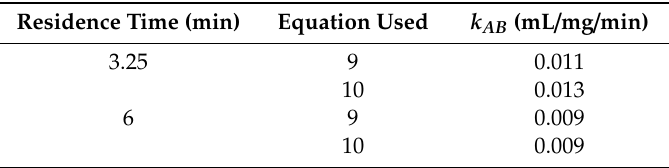
Figure 8. Linear regression fit of data to Adams–Bohart model. Values from these regressions were used in the calculation of kinetic constants in Tables 2 and 3. Table 2. Kinetic constants calculated from the slope.